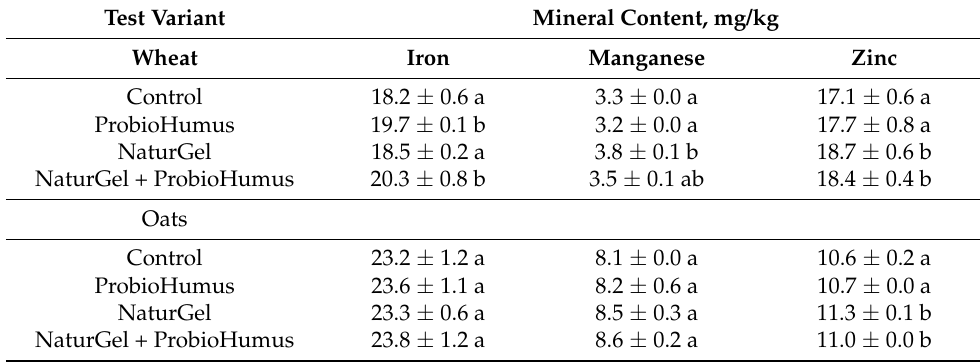
Table 6. Effect of probiotics on micronutrient content of wheat and oat grains.